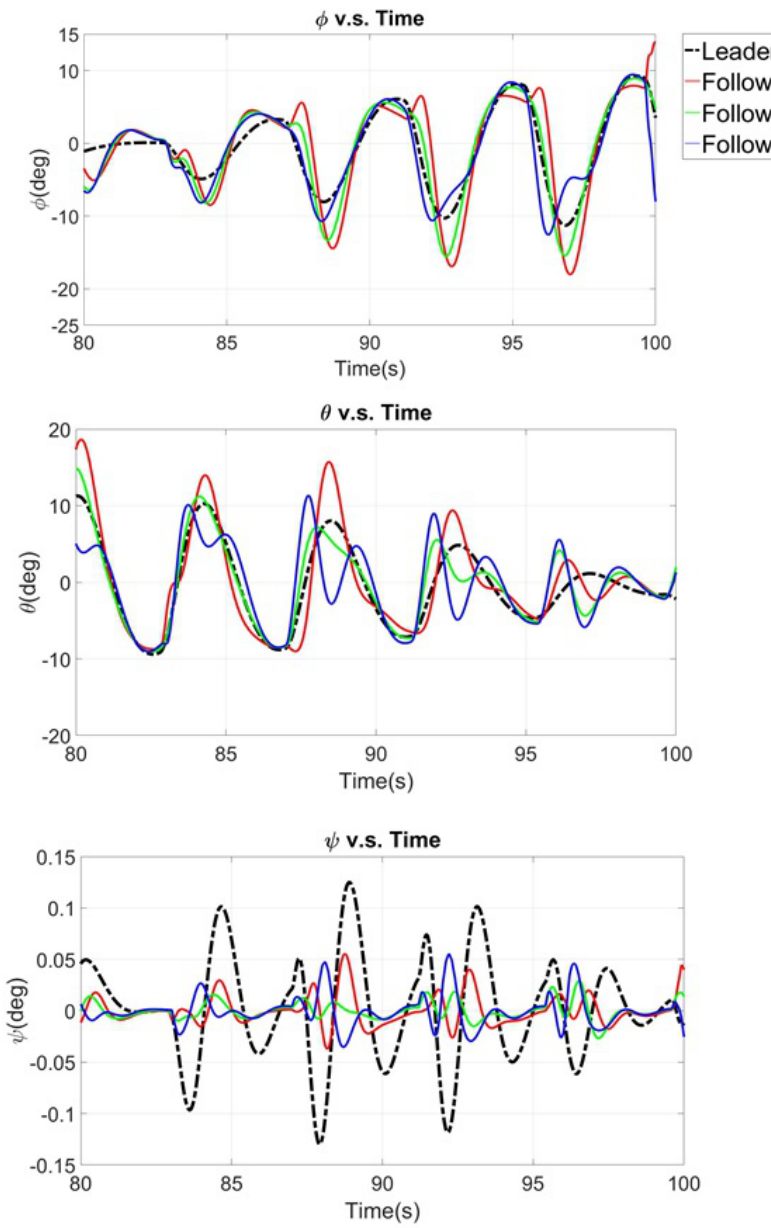
Figure 22. Zoom-in of altitude vs. time during upward circling